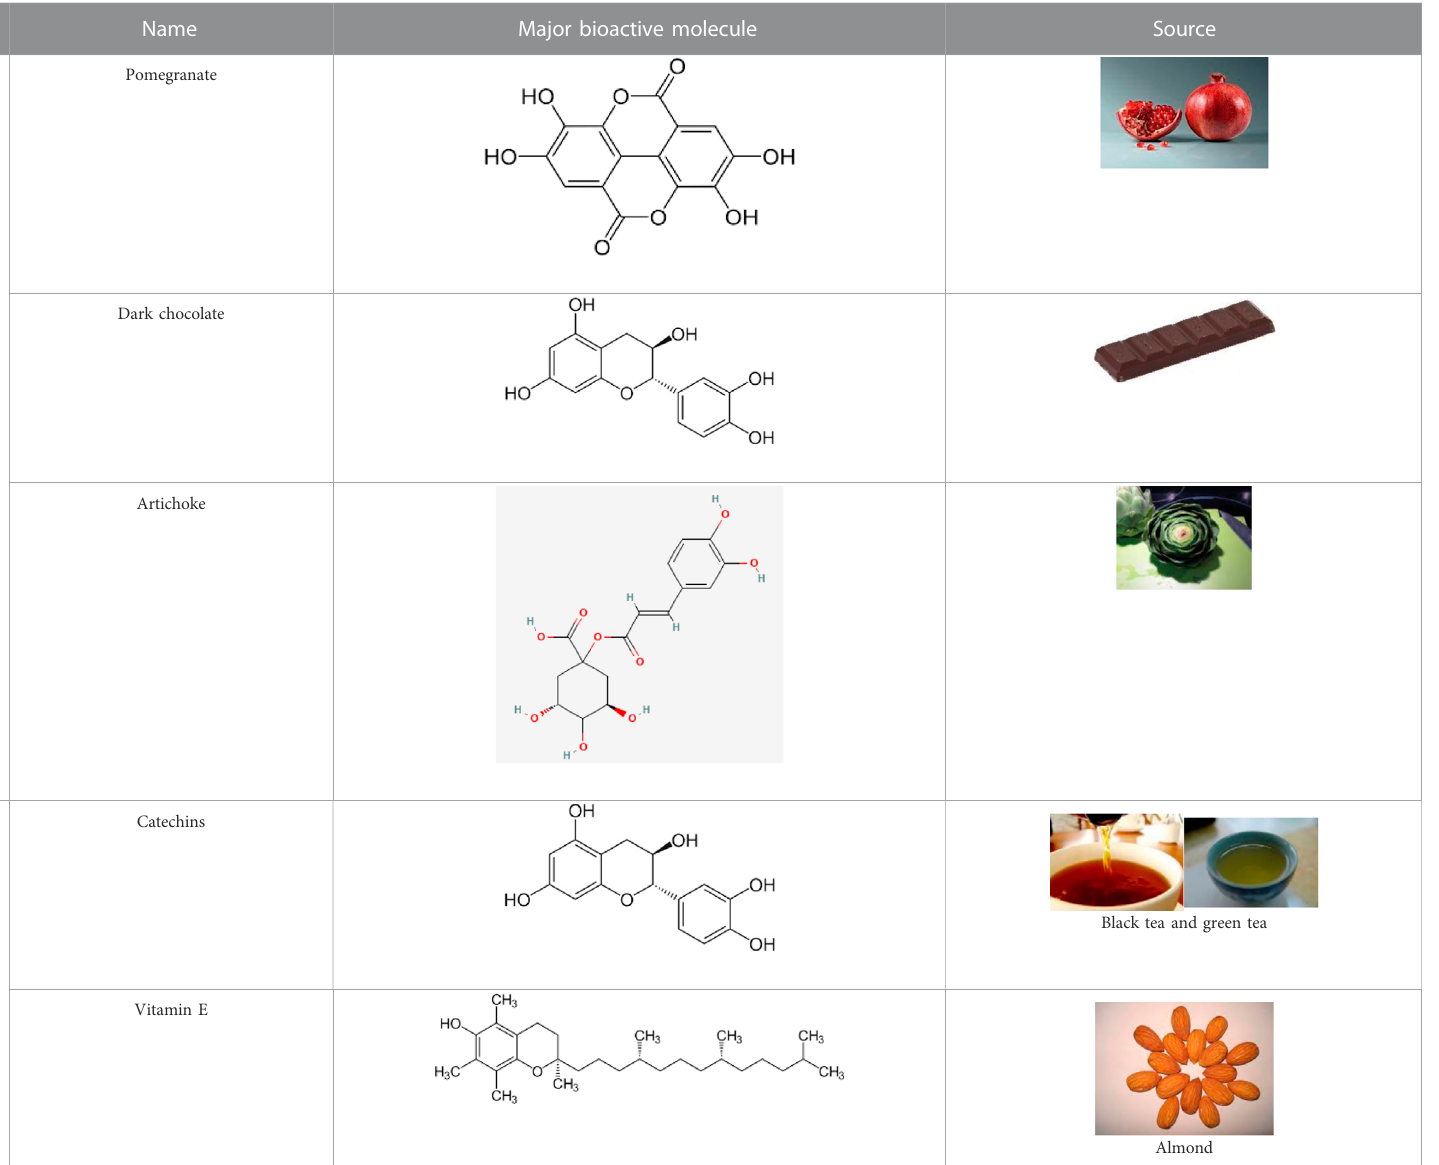
TABLE 2 Natural products (dietary foods, phytotherapeutics, and antioxidants) as therapeutic strategies to target various in fl ammatory and oxidative stress parameters of coronary heart